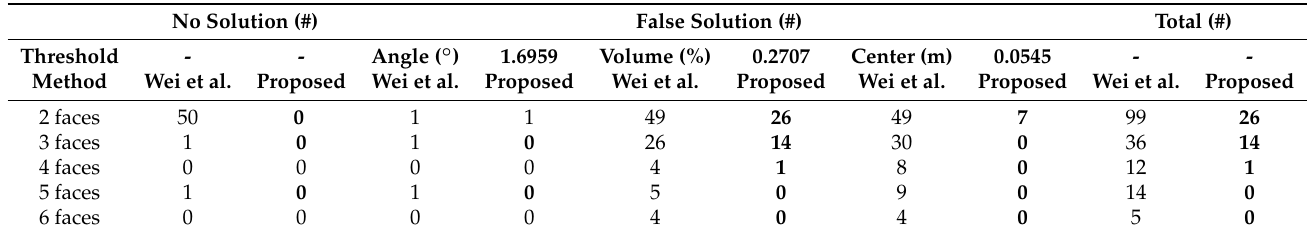
Table 1. Number of false and no solutions for synthetic data.